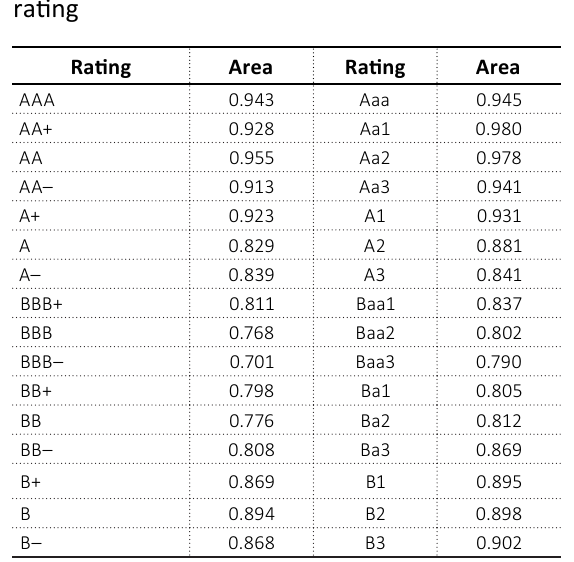
a deviation of two levels on both sides. For the test set, these proportions are 33.31%, 62.15% and 81.52%,